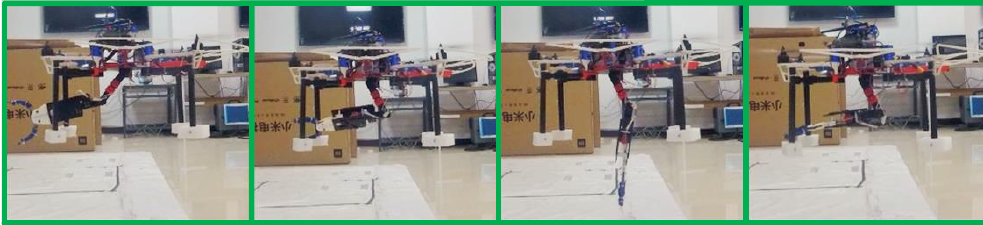
Figure 12. Snapshots of the robotic arm aerial moving experiments. Many movements are carried out during this flight to test the system. Each subfigure indicates a kind of movement of the robotic arm using in this